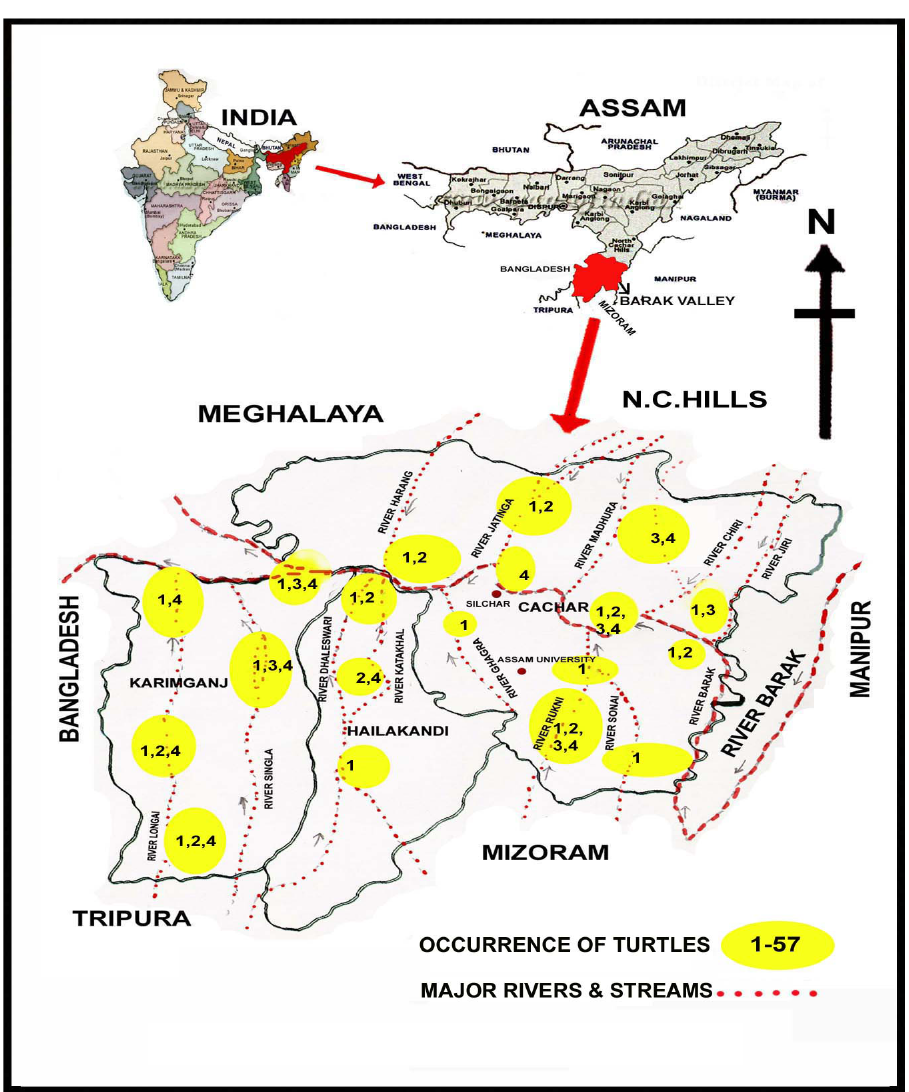
Figure 1. Map of Barak Valley showing sites of occurrence of Trionychid turtles. 1 - Nilssonia gangetica ; 2 - N. hurum ; 3 - Chitra indica ; 4 - Lissemys punctata andersonii ; → - Arrow signifies the flow of direction of